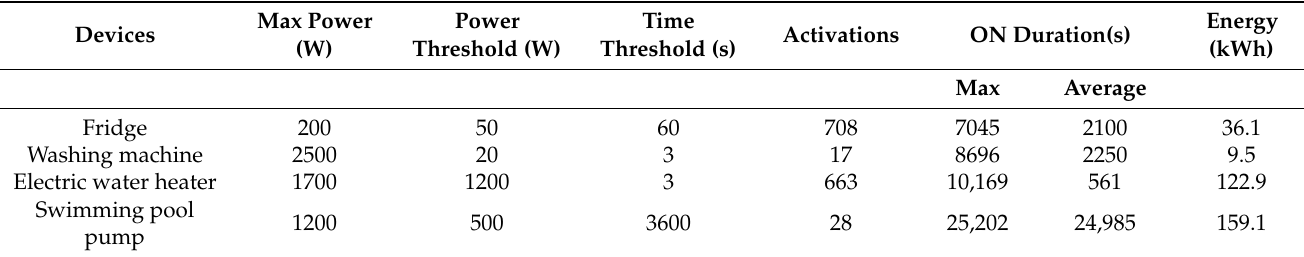
Table 1. Devices